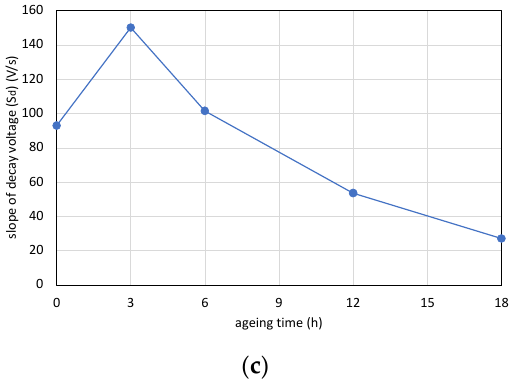
Figure 8. Changing of slope of decay voltages with aging time: ( a ) 110 °C, ( b ) 125 °C, and ( c ) 140 °C.